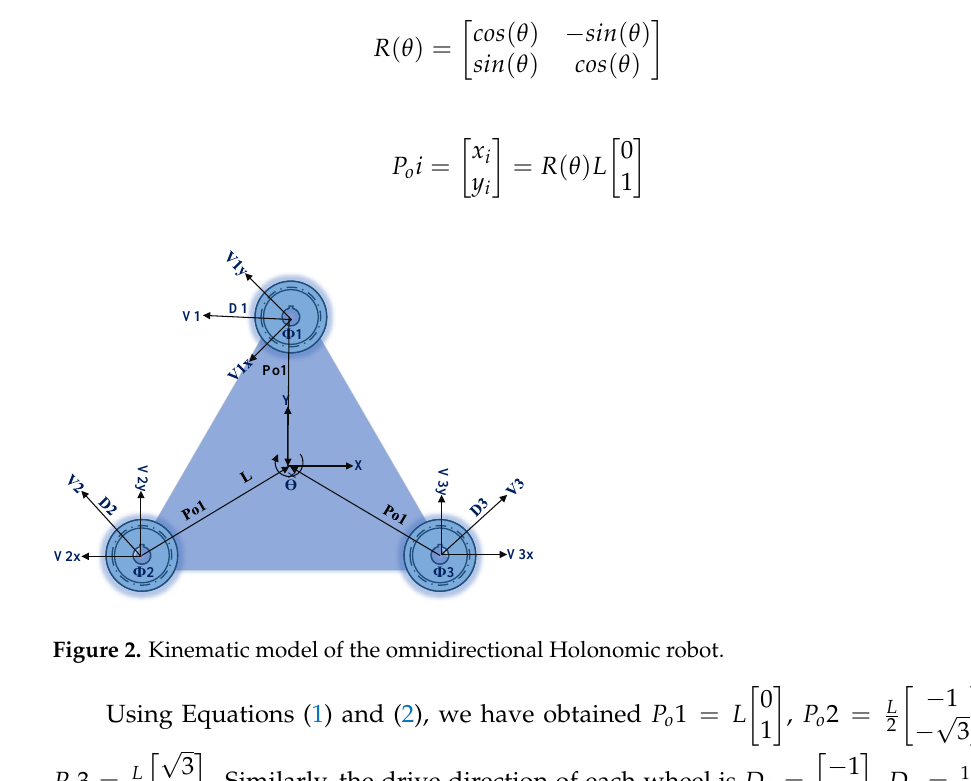
Figure 1. Difference between the motion of the Holonomic and Non-Holonomic robots. The Kinematic model of the Holonomic robot is shown in Figure 2. It provides three degrees of freedom and it can pose all three directives: x , y and θ . In our design, we have used Kiwi omnidirectional design where three omnidirectional wheels are mounted symmetrically at 120-degree angles and can move in all directions. Each wheel moves with the angular moment of the DC gear motors. The symmetrical distance between the center and wheel is represented as L . The center of gravity of the robot coincides with the center of the local frame. Moreover, three omnidirectional wheels are located with symmetrical angles of 120, as shown in Figure 2. The center of mass of TPR is represented with O, the vector connecting O to the origin is denoted with Po i ( i shows the number of wheel) and V i x , y is the direction vector of each omni wheel. The unitary rotation matrix, i.e., R ( θ ) , of TPR is given in Equation (1). Moreover, the vector connecting with the origin is shown in Equation (2).